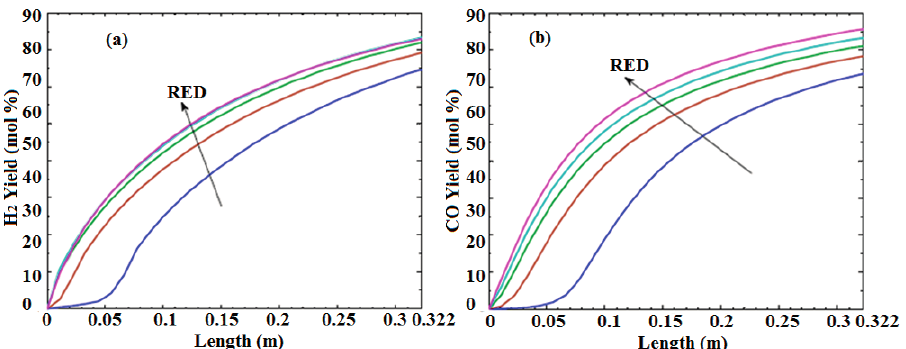
Figure 9. ( a ) H and ( b ) CO yields varying with increasing RED 2